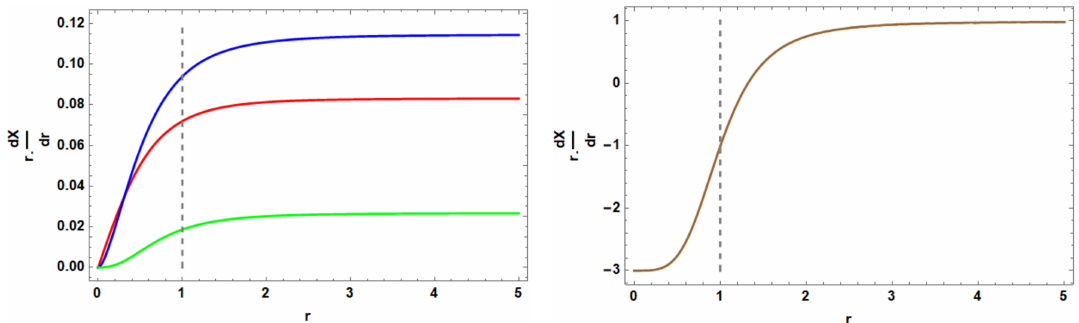
Figure 6. A flow from AdS to Kasner universe about the maximum of V. This corresponds to deformation parameter A 1 = 0 . 38 . For the left figure from top to bottom X are respectively φ 3 ( r ) , T φ 1 ( r ) and χ ( r ) . For the right figure X = log g 0 ( r ) . In the both figures dotted vertical line represents tt the position of horizon, r H